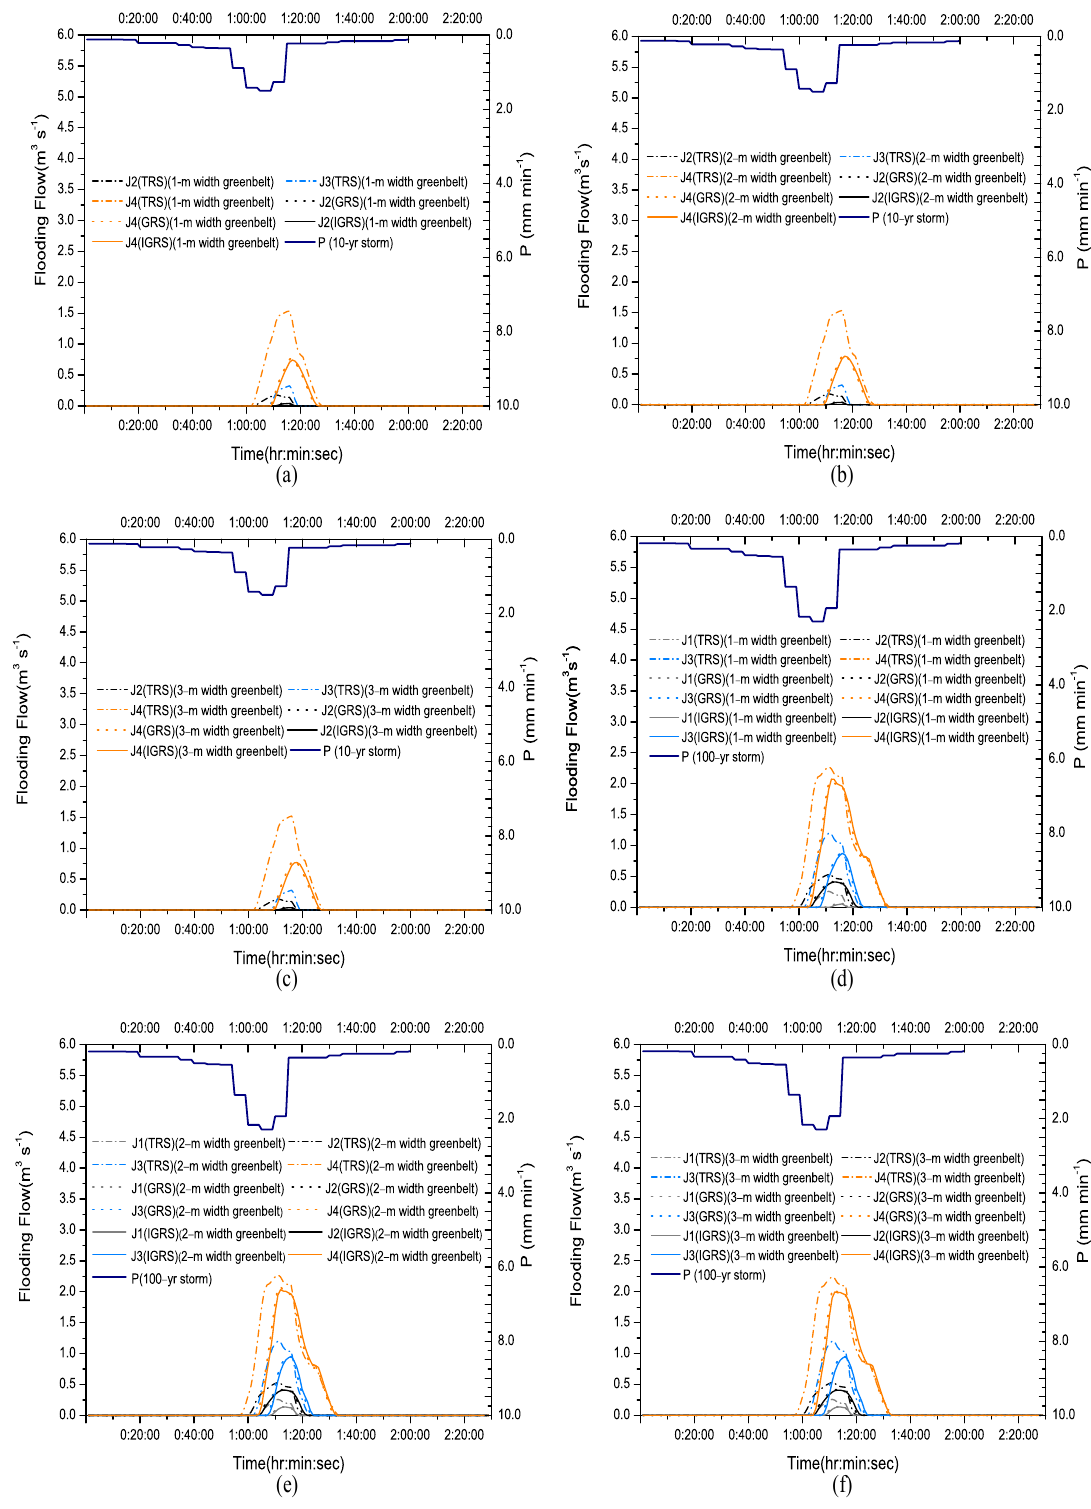
Figure 12. Comparison of the flooding nodes among the GRS, IGRS, and TRS for 2 single precipitation events (10-yr and 100-yr). ( a ) 10-yr storm (1-m width greenbelt); ( b ) 10-yr storm (2-m width greenbelt); ( c ) 10-yr storm (3-m width greenbelt); ( d ) 100-yr storm (1-m width greenbelt); ( e) 100-yr storm (2-m width greenbelt); ( f ) 100-yr storm (3-m width greenbelt).